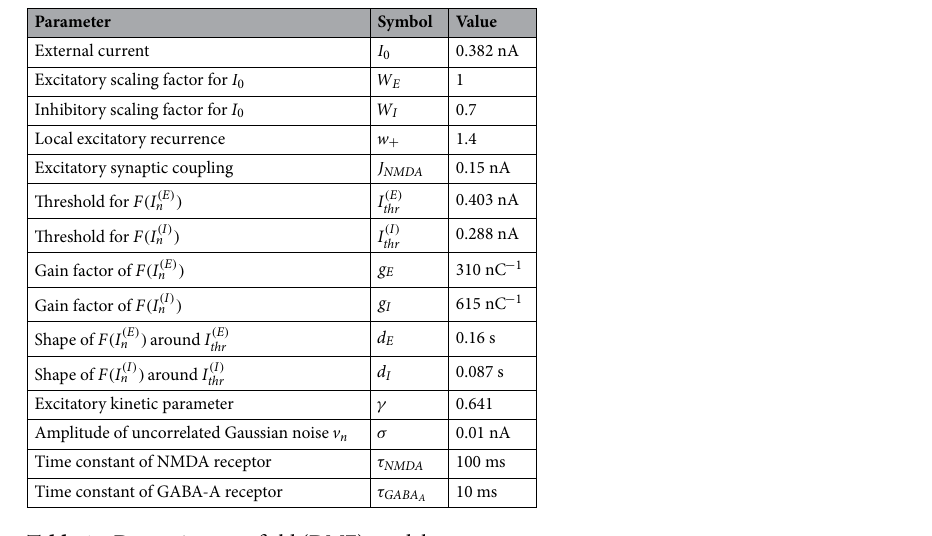
Table 1. Dynamic mean field (DMF) model